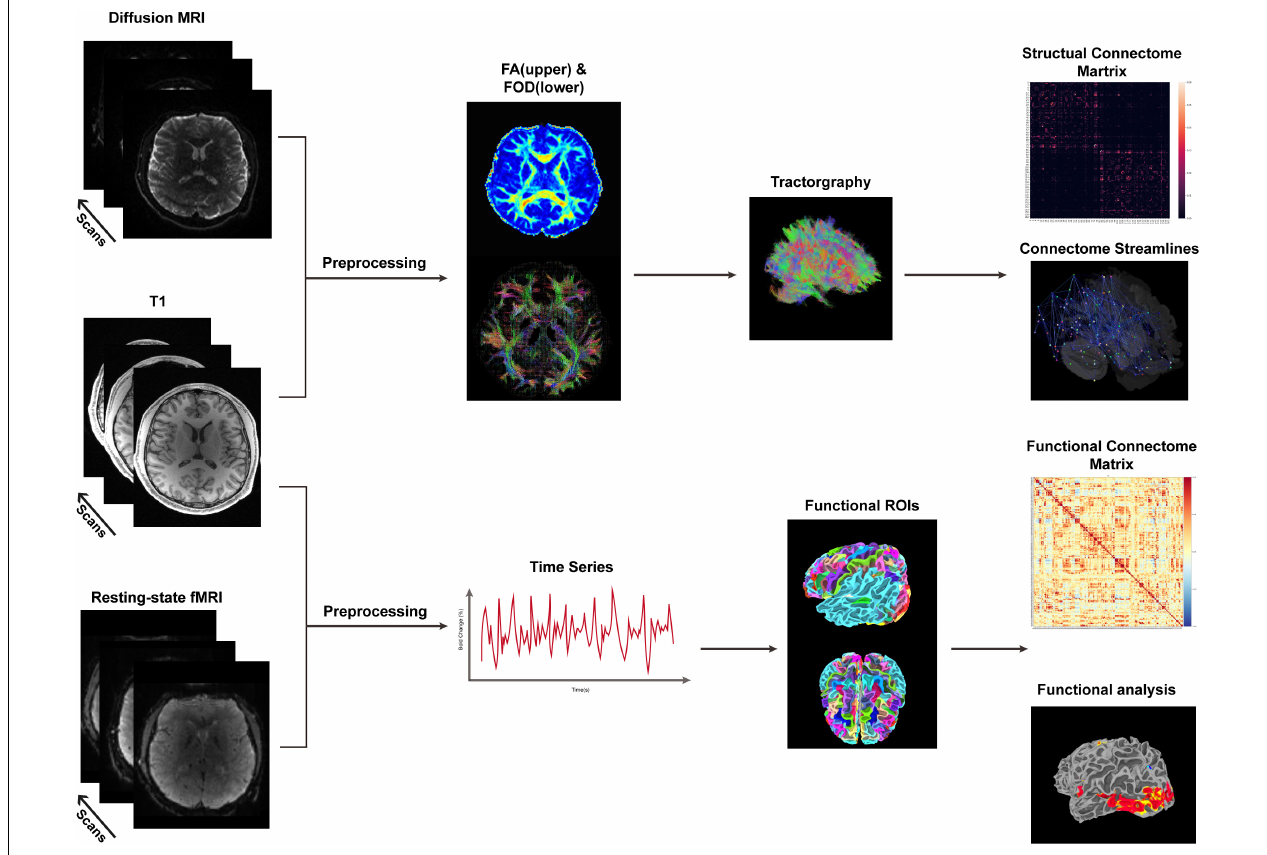
FIGURE 1 | Workflow of diffusion MRI (dMRI) and resting-state functional MRI (fMRI). After image acquisition, images obtained by dMRI and fMRI were initially preprocessed by denoise, bias correction, motion correction, alignment, etc. Then, in dMRI, fiber orientation distribution (FOD), and fractional anisotropy (FA) were calculated for tractography, followed by structural connectome evaluation. In fMRI, time series sequences were used to assess the brain functional activities. Besides, seed-based approaches were used for the analysis of regions of interests (ROIs) and the graph theory was employed for the whole-brain functional connectome